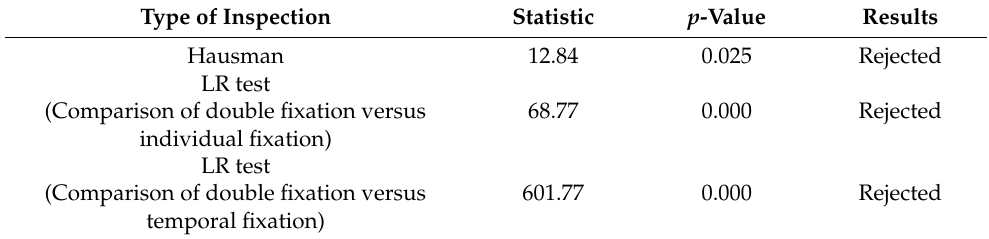
Table 3. Tests of